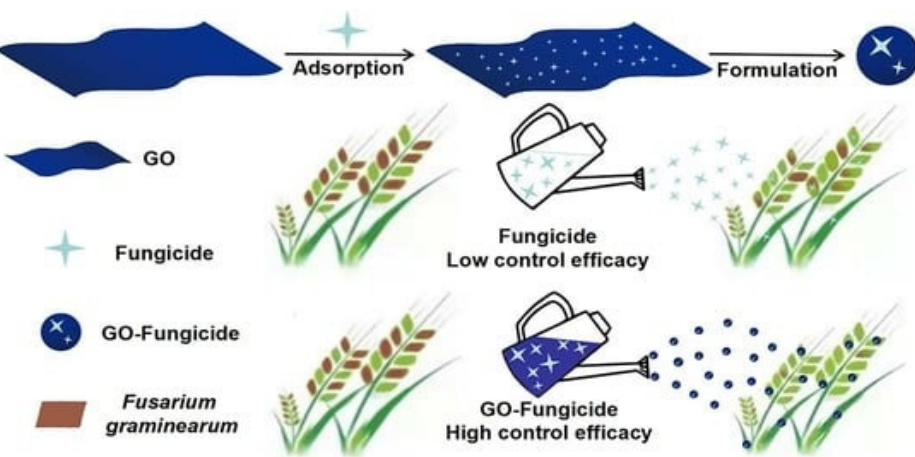
Figure 6. SEM images of the structural changes in the morphology of F. graminearum induced by fungicides, GO–fungicides and GO. Mycelia of the control ( A ), GO–treated (( E ), 100 µg/mL − 1 ), Man–treated (( B ), 20 µg mL − 1 ), Man–GO–treated (( F ), 20 µg mL − 1 ), Cyp–treated (( C ), 100 µg mL − 1 ), Cyp–GO–treated (( G ), 100 µg mL − 1 ), Dif–treated (( D ), 200 µg mL − 1 ) and Dif–GO–treated (( H ), 200 µg mL − 1 ) F. graminearum , respectively [134].